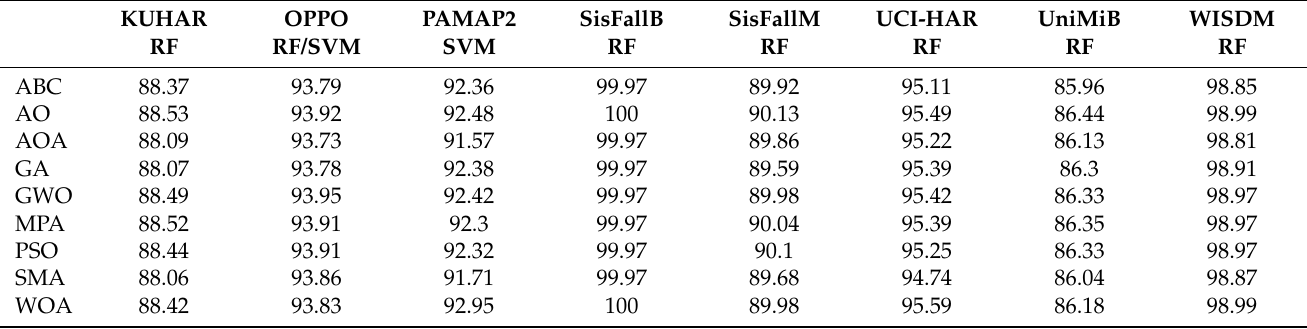
Table 3. Classification accuracy (%) of the best model for each